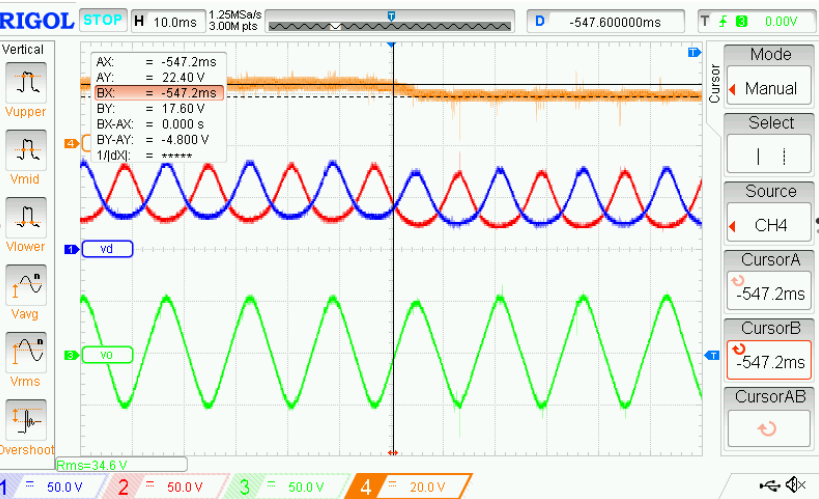
Figure 24. Measurement of capacitor voltages and voltage across the load when the supply is changed.